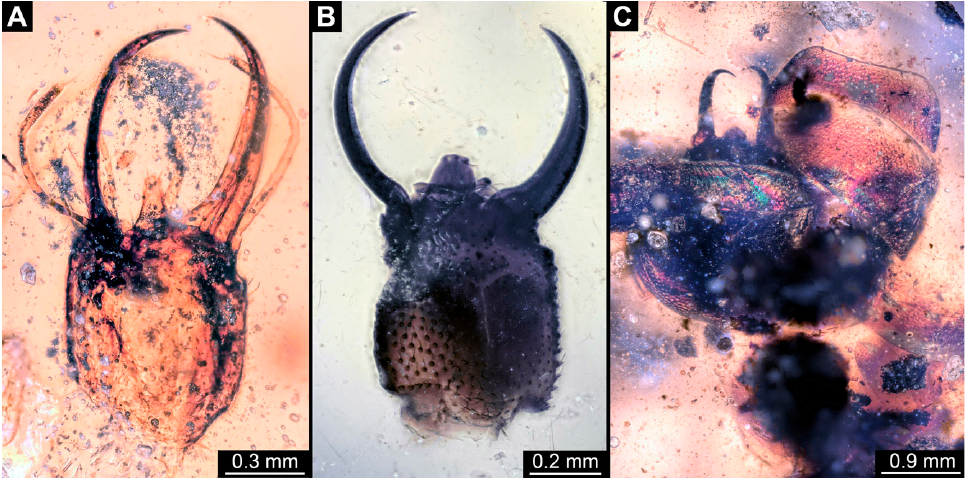
Figure 28. Specimens in Myanmar amber. ( A ) Specimen 94 (PED 2446). ( B ) Specimen 93 (PED 2329). ( C ) Specimen 95 (PED 2448). (42) Specimen 94 (PED 2446) is preserved in Cretaceous amber from Myanmar (Fig-